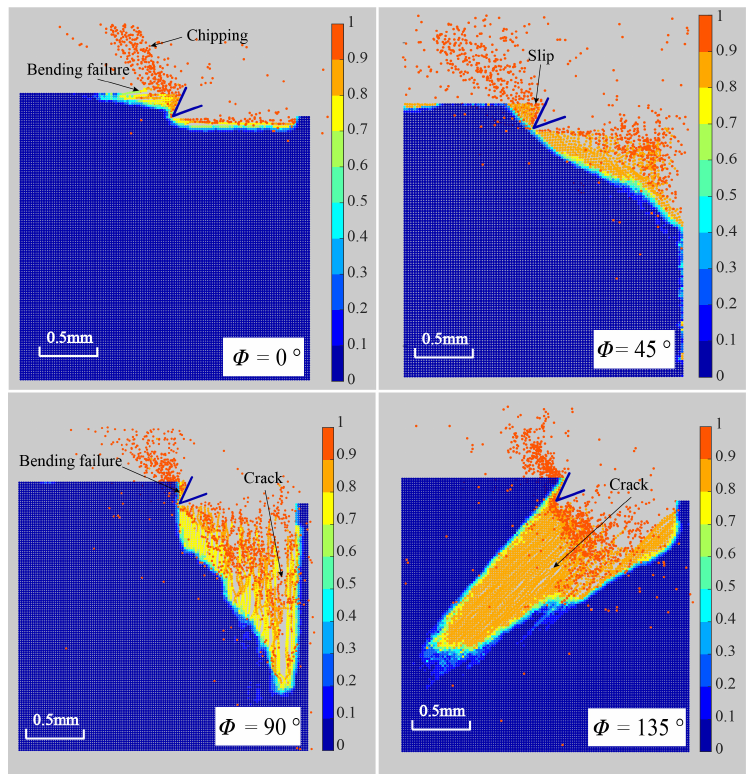
Figure 10. Chip formation for φ = 0 ◦ ,45 ◦ ,90 ◦ ,135 ◦ (partial enlarged